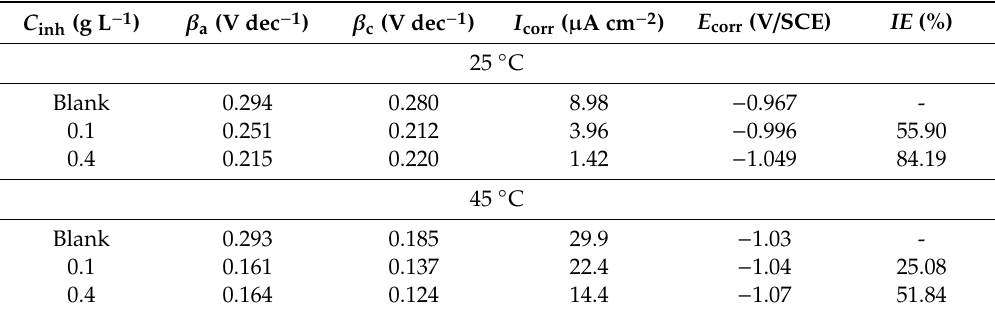
Figure 2. Polarisation curves for pure aluminium in 1-M HCl in the absence and presence of different concentrations of GG at 25 °C (a) and 45 °C (b) after 24 h of immersion. Table 2. Potentiodynamic polarisation parameters for pure aluminium without and with different concentrations of GG at 25 and 45 ◦ C after 24 h of immersion.